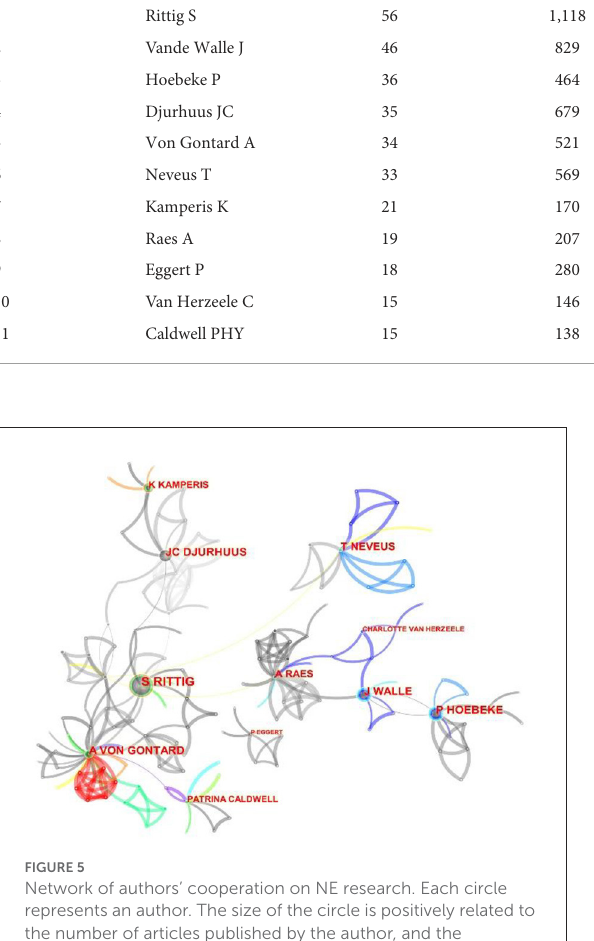
reliable. When the Q value is > 0.5, it indicates that the